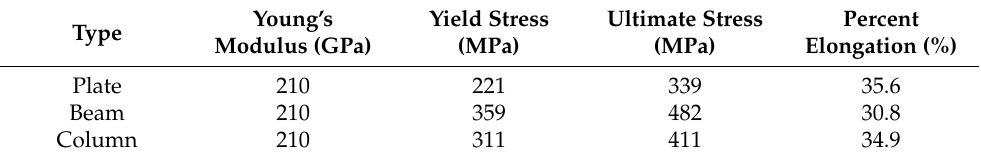
Figure 4. Details of connections.